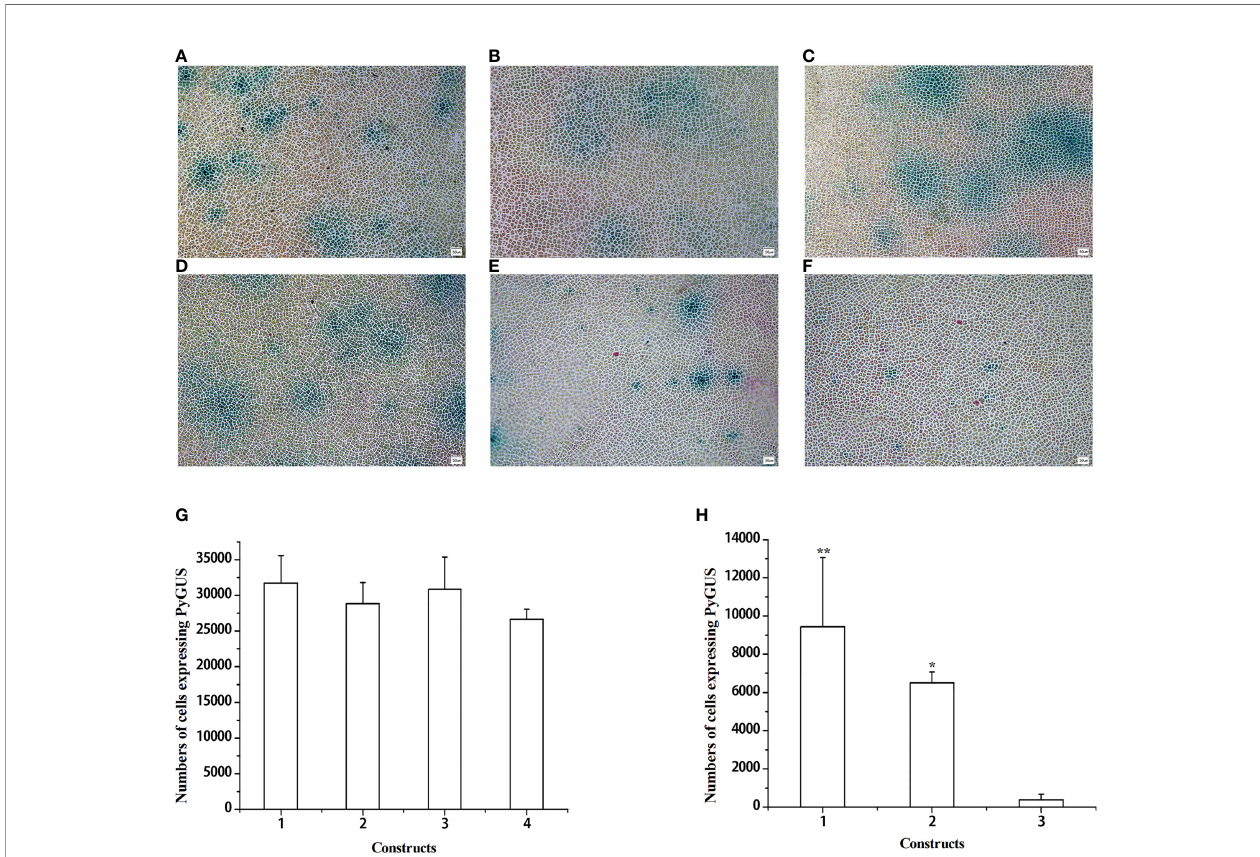
FIGURE 3 | Expression of PyGUS driven by different promoters in gametophytic cells of N. yezoensis. Gametophytic cells of N. yezoensis were transformed with expression plasmids using different promoters. PBI121-p PyACT 1- PyGUS (A) , PBI121-p PyACT 2- PyGUS (B) , PBI121-p PyACT 3- PyGUS (C) , PBI121-p PyACT 4- PyGUS (D) , PBI121-p PyACT 5-PyGUS (E) , and PBI121-p PyACT6-PyGUS (F) . Blue cell spots indicate cells expressing PyGUS. (G, H) Comparison of the numbers of cells expressing PyGUS with different lengths of p PyACT promoters in N. yezoensis. (G) Plasmids with different lengths of p PyACT promoters for transformation were as follows: (1) PBI121-p PyACT 1- PyGUS , (2) PBI121-p PyACT2-PyGUS , (3) PBI121-p PyACT3-PyGUS , and (4) PBI121-p PyACT4-PyGUS . (H) Plasmids with different lengths of p PyACT promoters for transformation were as follows: (1) PBI121-p PyACT4-PyGUS , (2) PBI121- pPyACT5-PyGUS , and (3) PBI121-p PyACT6-PyGUS . Scale bars indicate 50 mm. Data are expressed as mean ± SD (n = 3). *P < 0.05; **P < 0.01 by analysis of